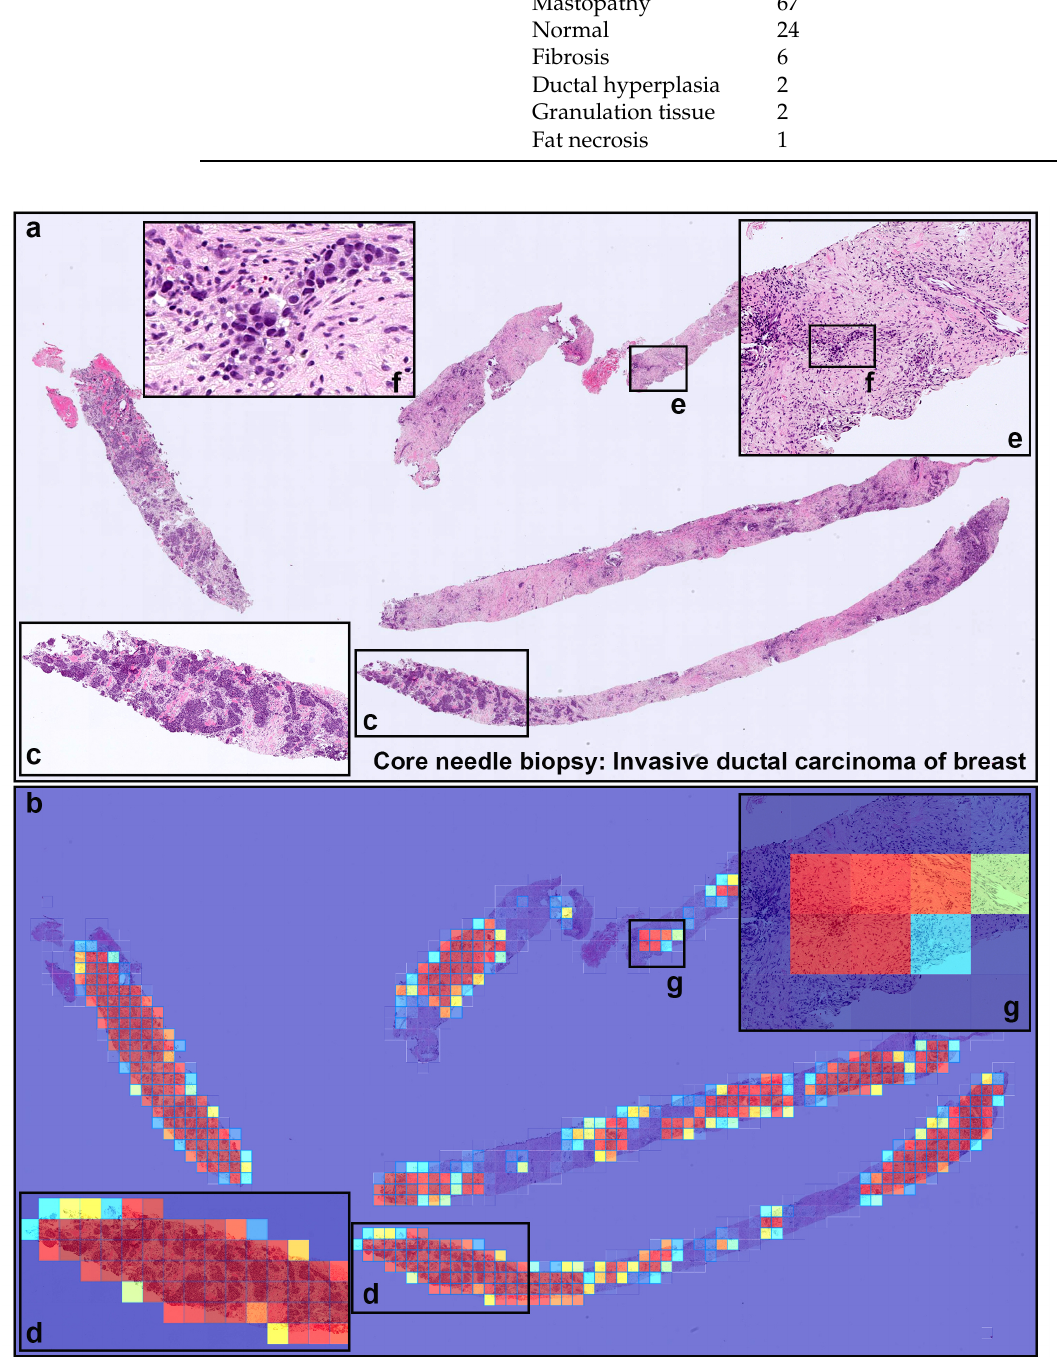
Figure 4. A representative true positive invasive ductal carcinoma (IDC) of breast from core needle biopsy test set. Heatmap images show true positive predictions of IDC cells ( b ) and they correspond, respectively, to H and E histopathology ( a ) using transfer learning from ImageNet model (magnification × 10). Not only abundant IDC cells invading areas ( c ) but also a few IDC cells ( e , f ), heatmap images show appropriately true positive predictions ( d , g